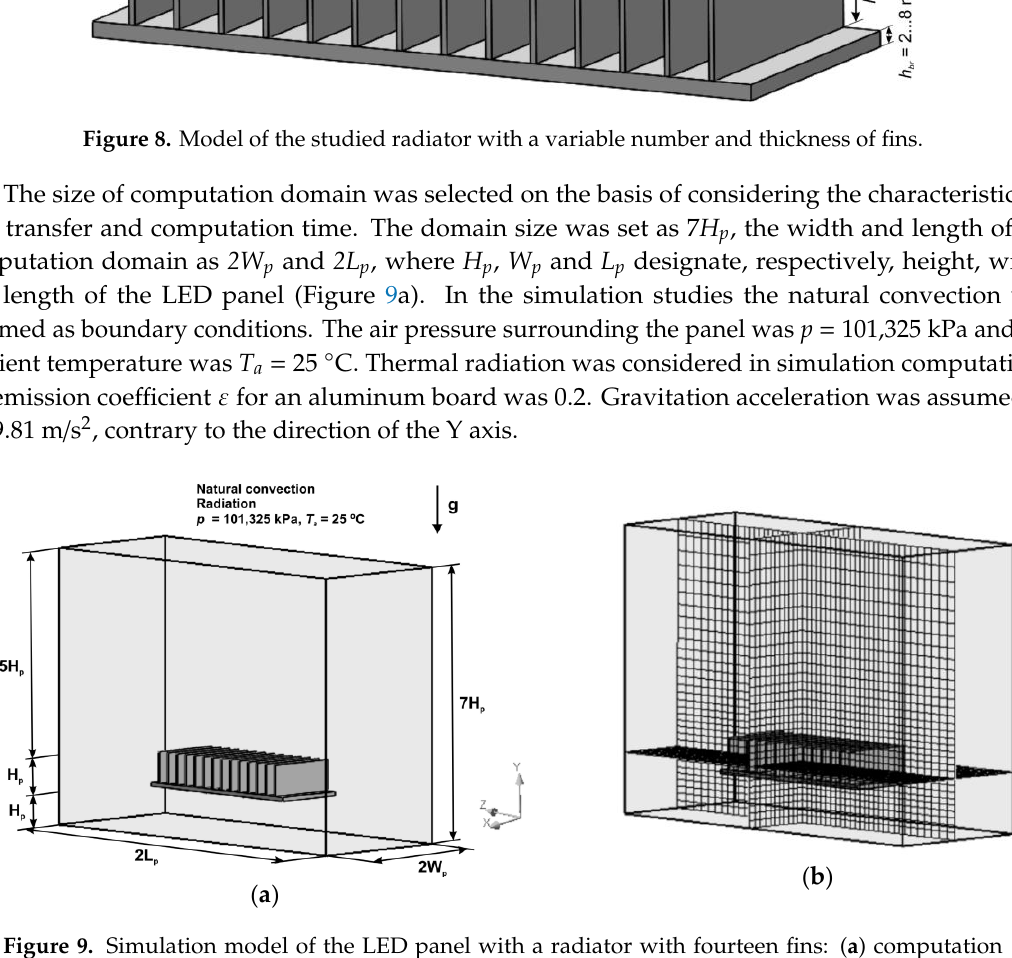
Figure 8. Model of the studied radiator with a variable number and thickness of fins.